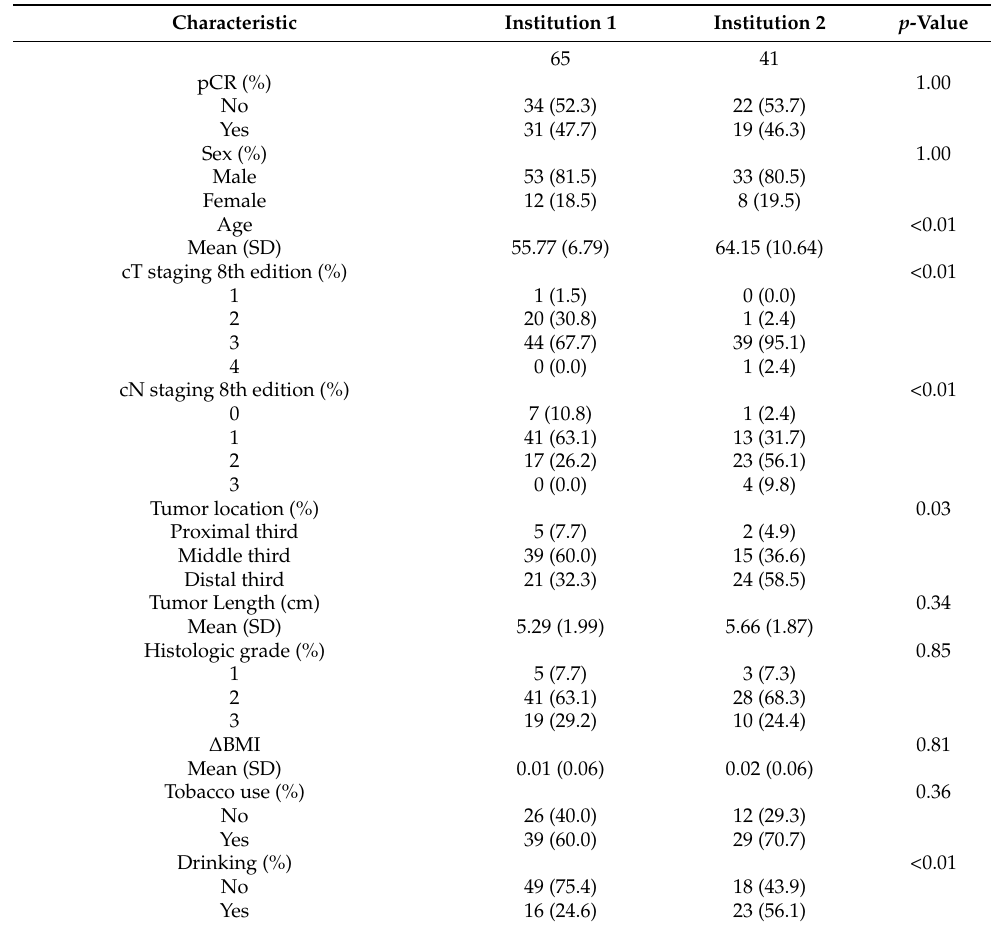
Table 1. Patients’ clinical